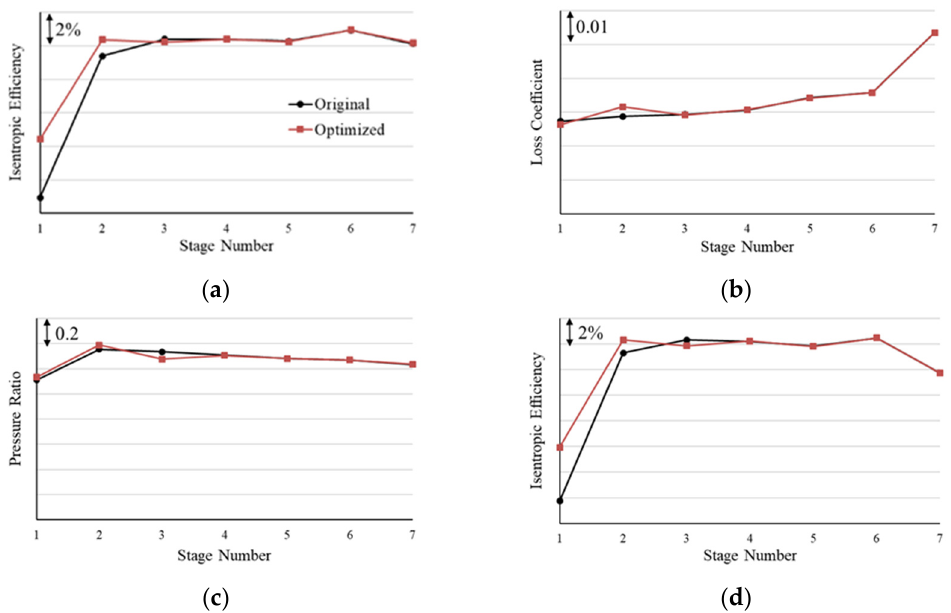
Figure 13. Performance changes of stages and blades during VGV2 adjustment. ( a ) Efficiency of rotors; ( b ) loss of stators; ( c ) pressure ratio of stages; ( d ) efficiency of stages.